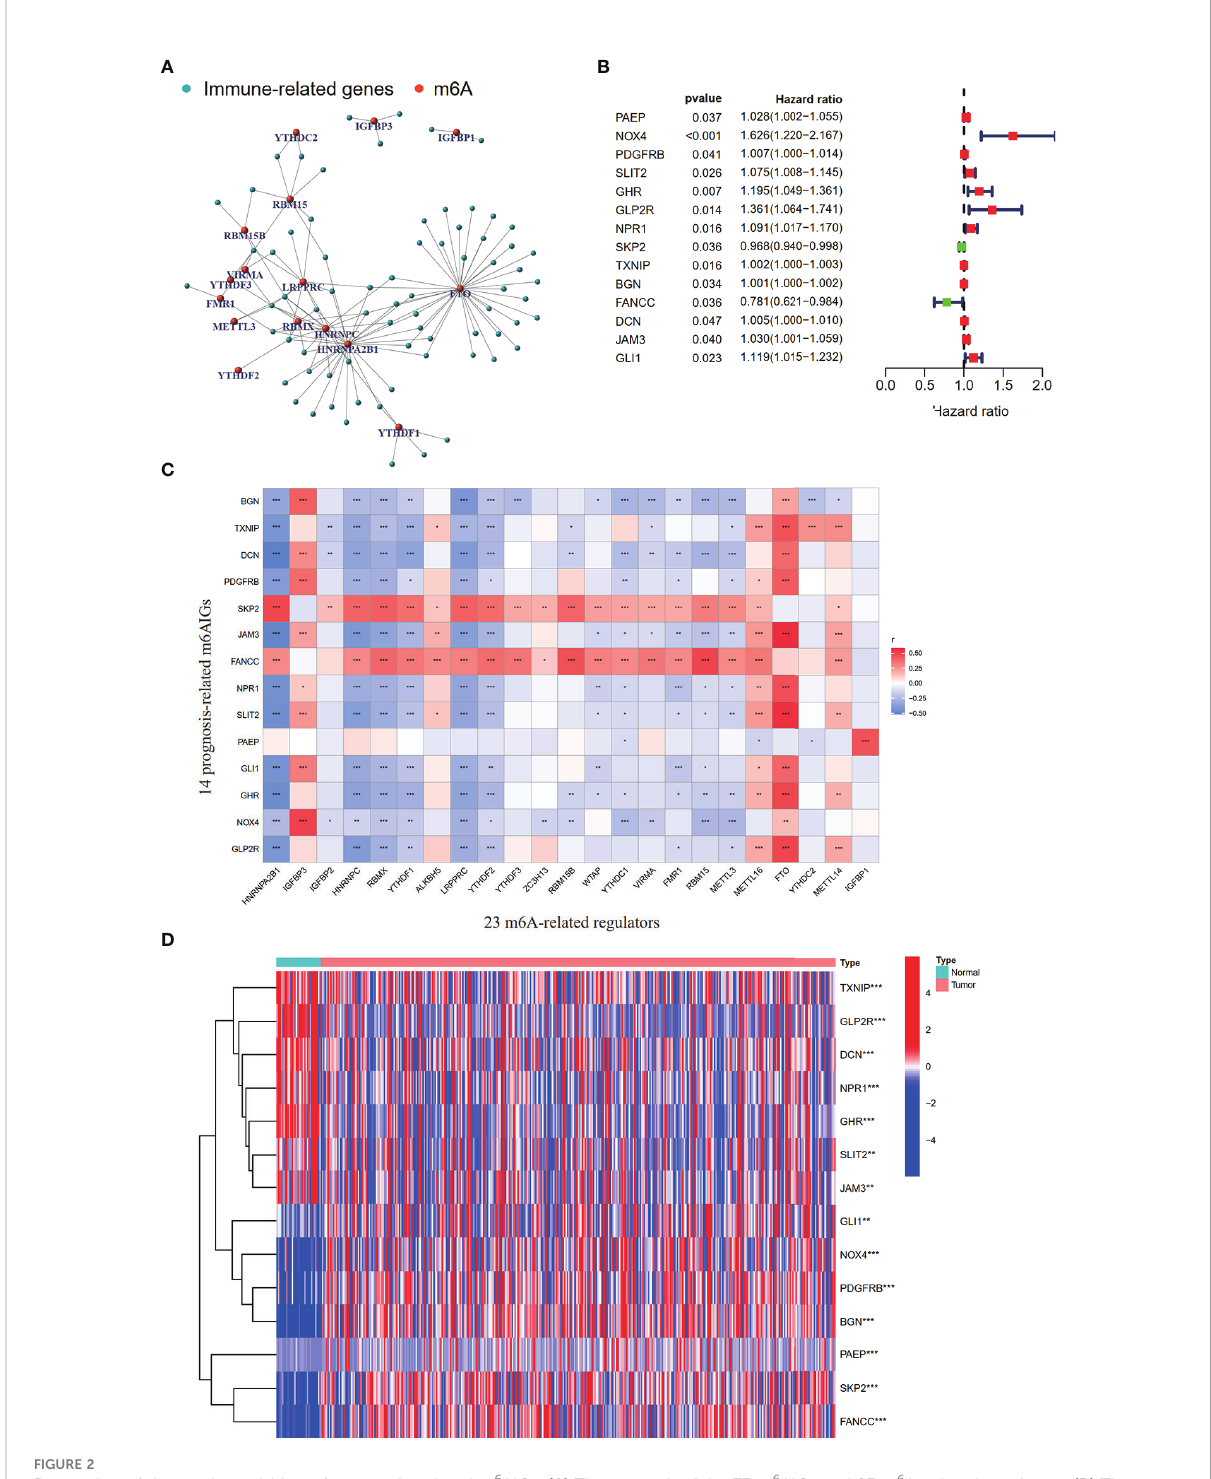
FIGURE 2 Processing of data and acquisition of prognosis-related m 6 AIGs. (A) The network of the 73 m 6 AIGs and 23 m 6 A-related regulators. (B) The hazard ratio 95% con fi dence interval of 14 prognostic m 6 AIGs were estimated by univariate Cox regression. (C) Pearson correlation analysis between 23 m 6 A-related regulators and 14 prognostic m 6 AIGs. (D) The heatmap with differential expression of 14 prognostic m 6 AIGs between the tumor group and the normal group.* p < 0.05, ** p < 0.01, *** p <